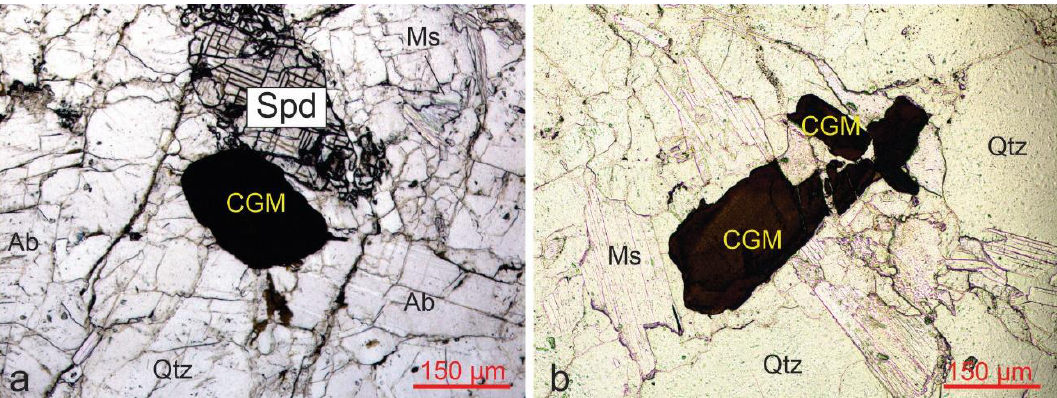
Figure 4. Photomicrographs showing typical CGM-bearing mineral assemblages in the investigated Li-rich pegmatites at Kalu’an. ( a ) coexisting CGM and spodumene that are associated with quartz, albite, and muscovite, ( b ) CGM associated with quartz and muscovite. Both photomicrographs were taken in plane-polarized transmitted light. Abbreviations: Ab = albite, CGM = columbite-group mineral, Ms = muscovite, Spd = spodumene, and Qtz = quartz.